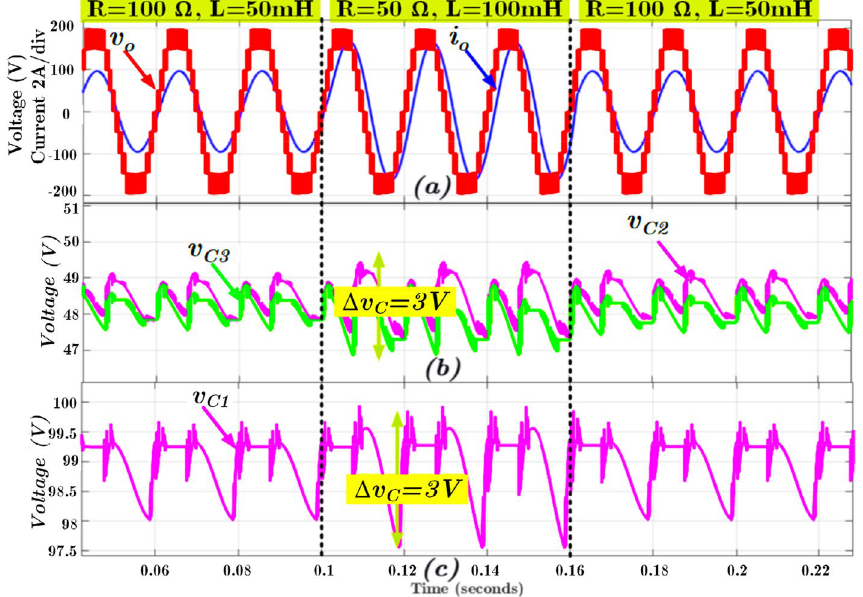
Figure 4. Simulation results of ( a ) output voltage and current; ( b ) voltages of the FCs C 2 and C 3 , and ( c ) voltage of the FC C 1 .